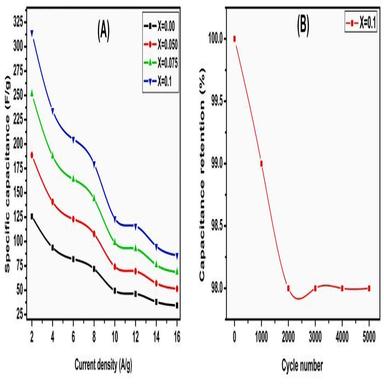
(a) Variation of specific capacitance vs current density for CoFe2-xSmxO4 (x = 0.0, x = 0.050, x = 0.075 and x = 0.1 ferrites (b). Capacitance retention percentage vs cycle number for x = 0.1 ferrites.